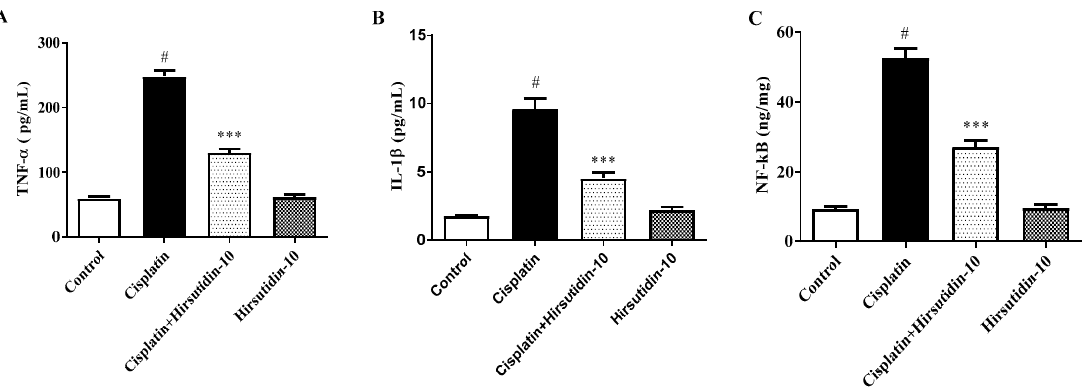
Figure 3. ( A – C ) Effects of hirsutidin on anti-inflammatory parameters for the nephrotoxicity induced by cisplatin in rats. ( A ) TNF α . ( B ) IL-1 β . ( C ) NF-kB; one-way ANOVA followed by Tukey’s post-hoc test. # p < 0.001 vs. control (group I), *** p < 0.001 vs. cisplatin (group II).